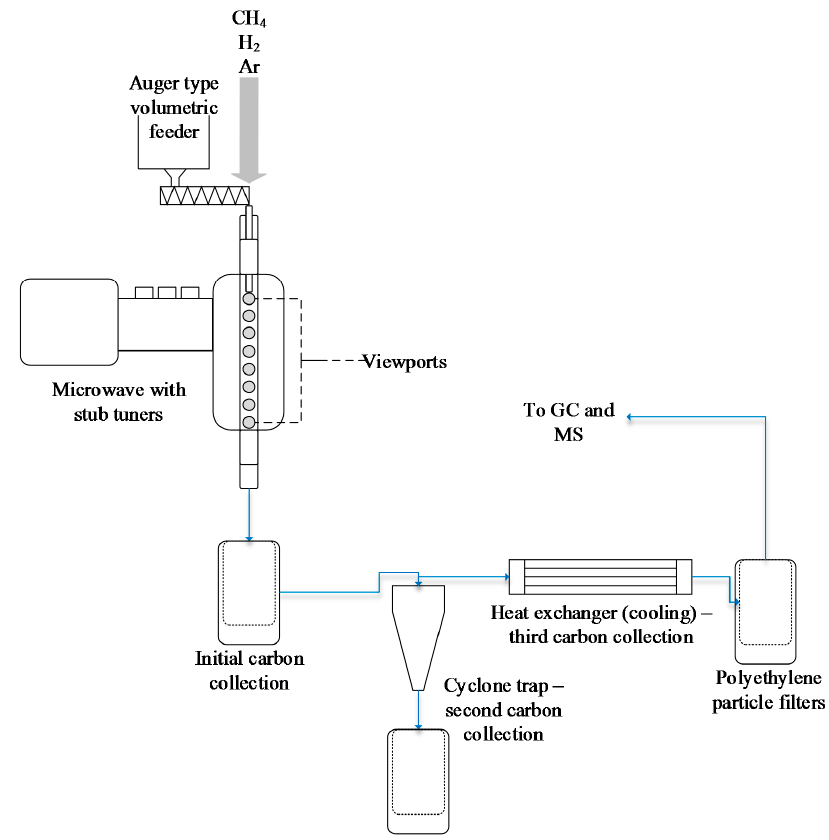
Figure 1. Schematic of Wave Liquefaction reactor and solid carbon collection.